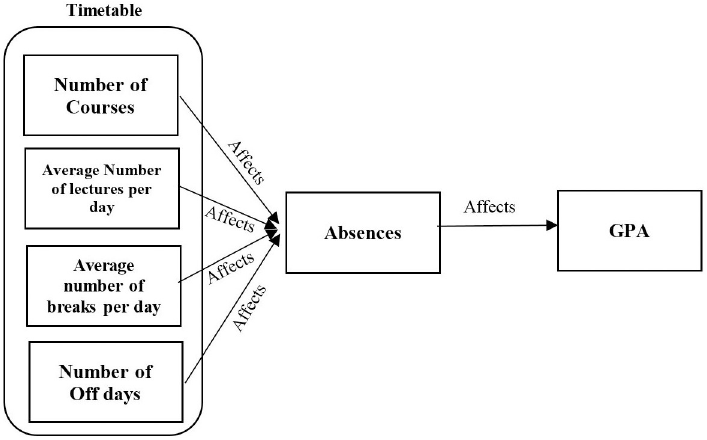
Fig 1. Impact on student’s GPA by the number of students’ absences due to timetabling factors.